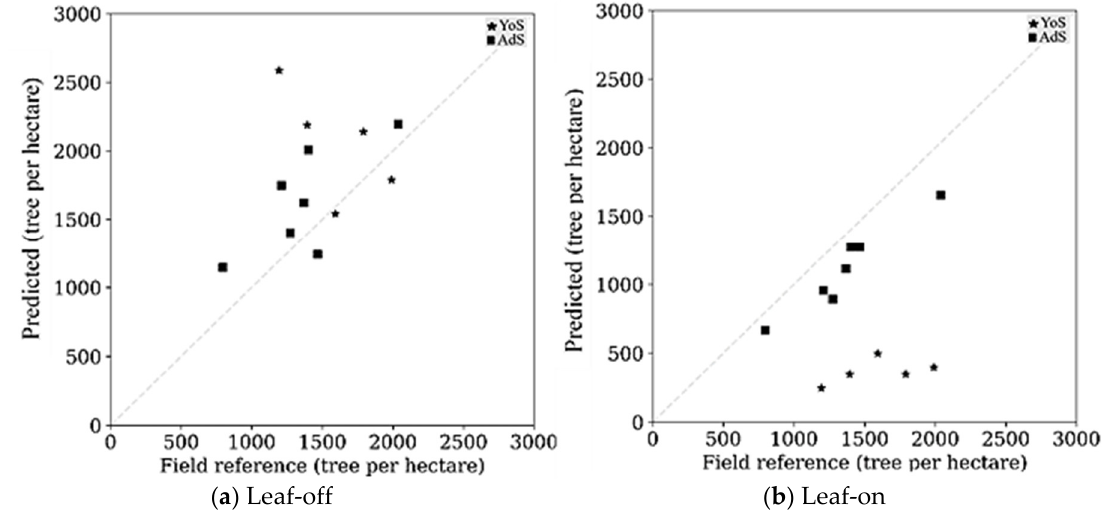
Figure 6. Tree density (unit: tree per hectare) of Norway spruce seedlings in leaf-off ( a ) and leaf-on ( b ) conditions, separating plots in young seedling stand (YoS, n = 5) and advanced seedling stand (AdS, n = 7) in canopy thresholds of 0.4 m. Table 7. Evaluation of the accuracy of Norway spruce tree density among all ( n = 12 ), young seedling (YoS, n = 5 ), and advanced seedling (AdS, n = 7 ) plots in leaf-off and leaf-on conditions in each of the canopy thresholds (C th s). Unit: trees per hectare. Leaf-Off Leaf-On